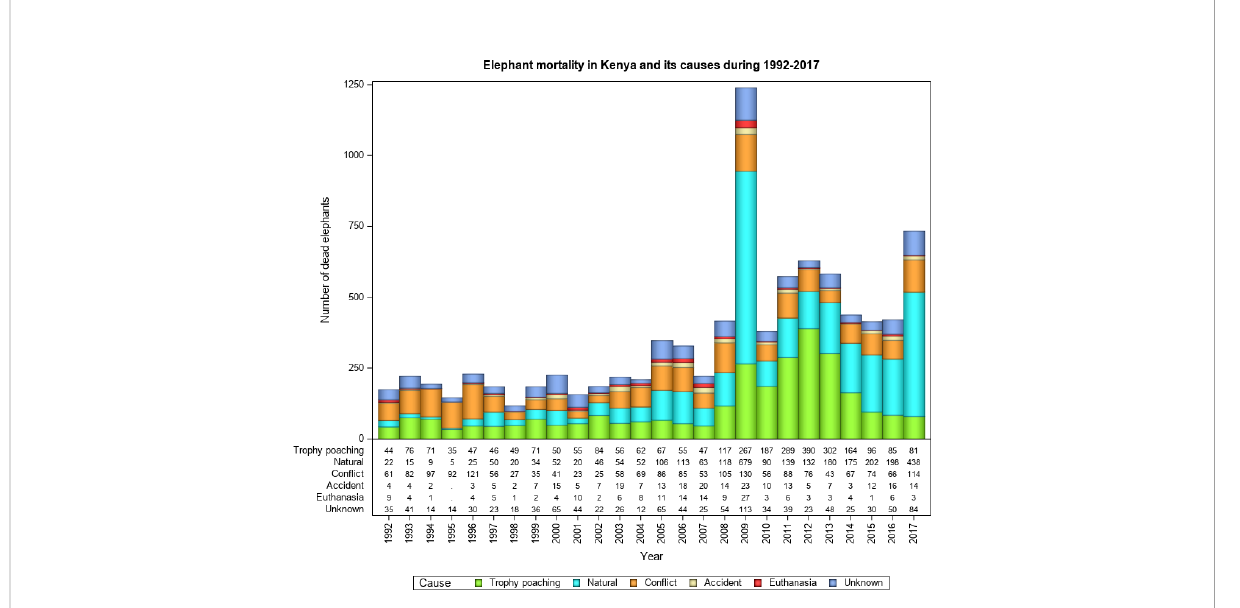
FIGURE 3 Elephant mortality and its causes in Kenya during 1992 -